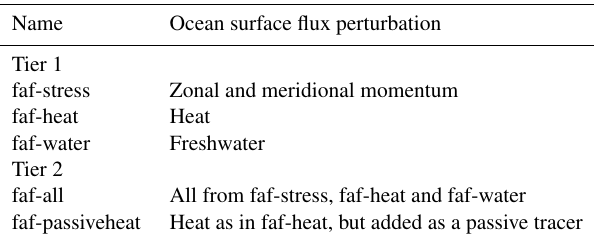
Table 1. FAFMIP experiments. Name Ocean surface flux perturbation